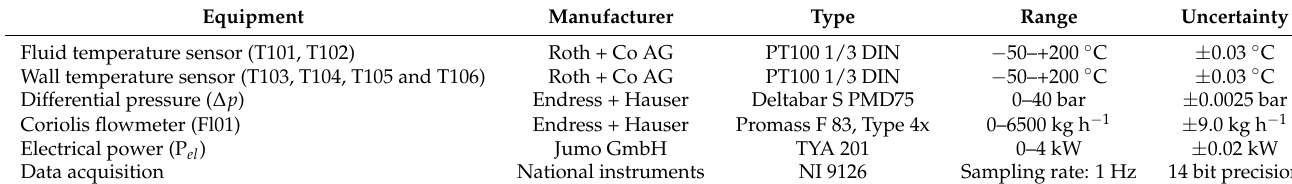
Table 5. Specifications and details of all the sensors used in the experimental investigation.